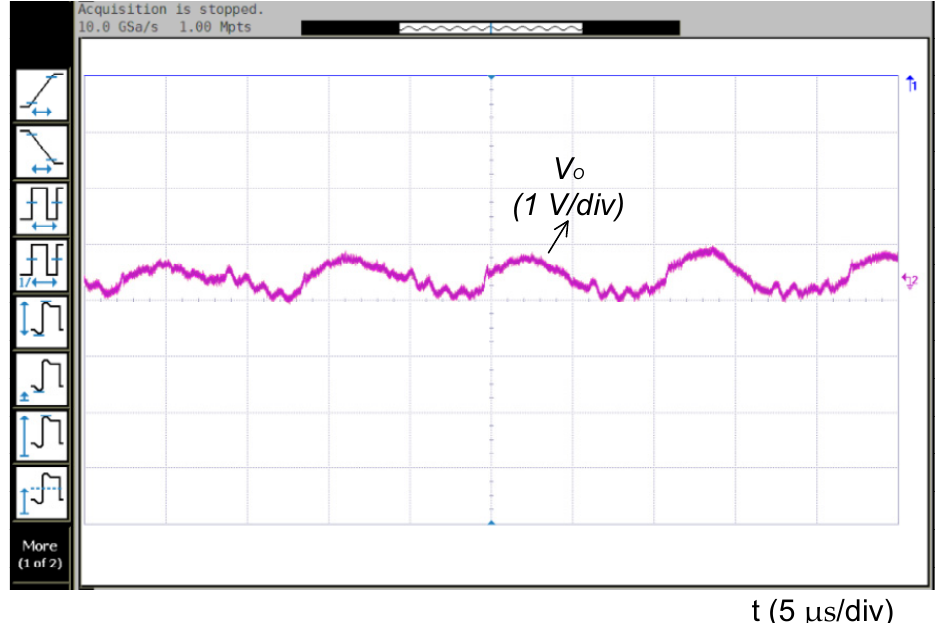
Figure 12. Test value of the output high voltage obtained by a digital multimeter.